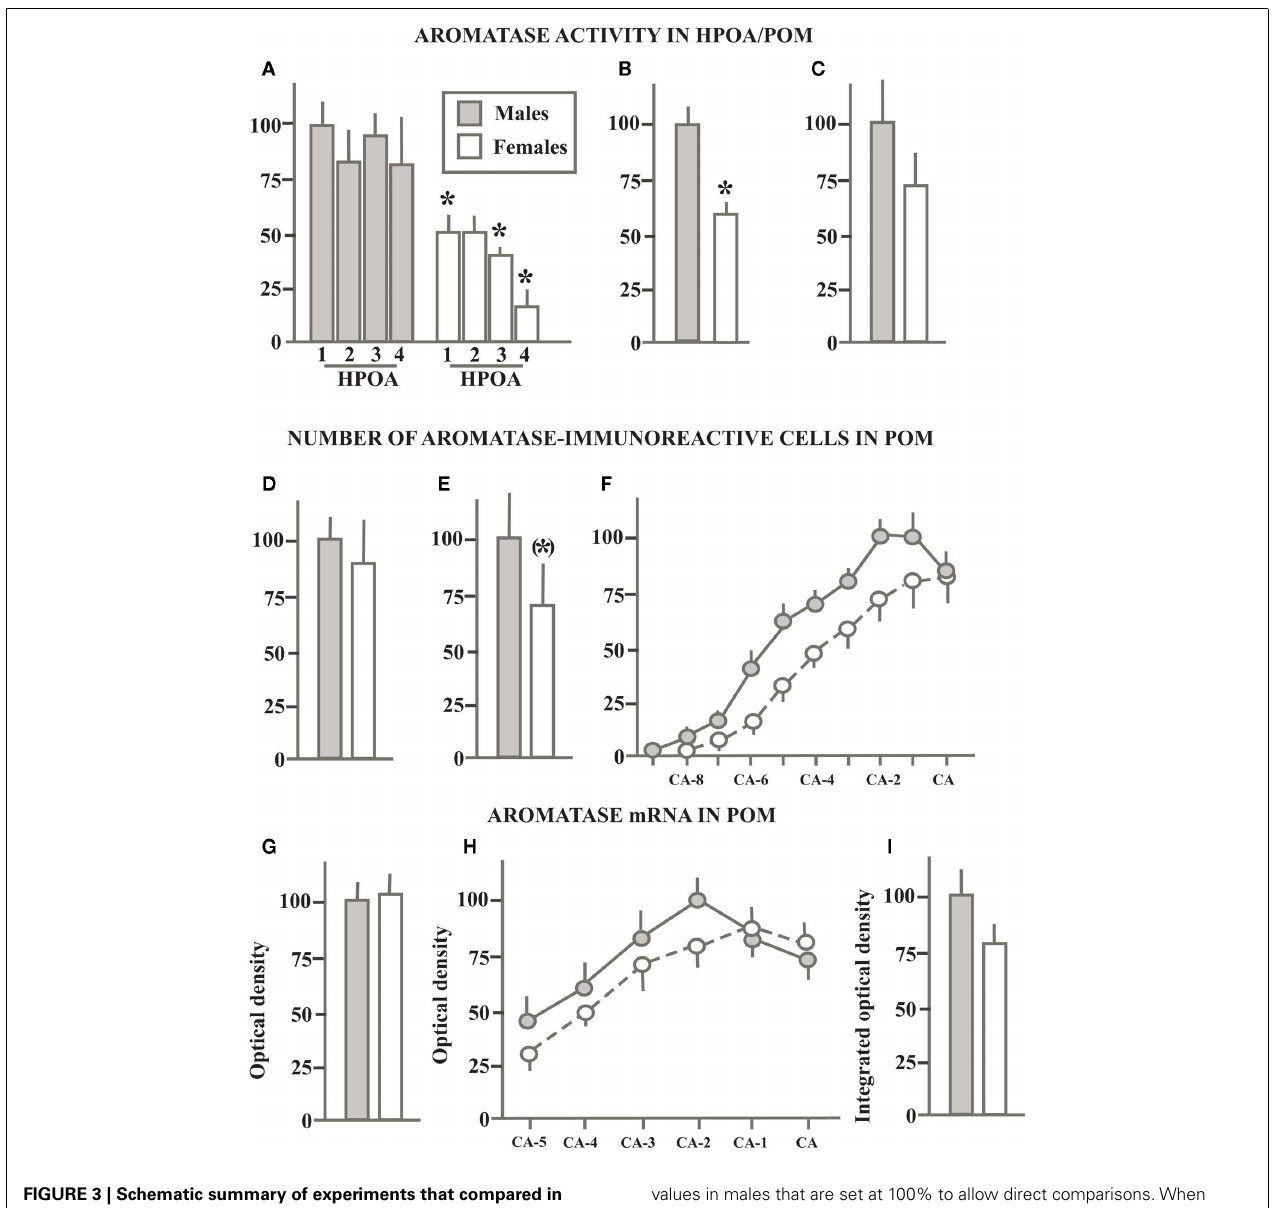
FIGURE 3 | Schematic summary of experiments that compared in sexually mature gonadally intact male and female quail the aromatase activity in the preoptic area (A) or in the medial preoptic nucleus specifically (B,C), the number of aromatase- immunoreactive cells in the POM (D–F) and the density of aromatase mRNA (G–I) quantified by radioactive in situ hybridization. All data are expressed in percentage of the corresponding